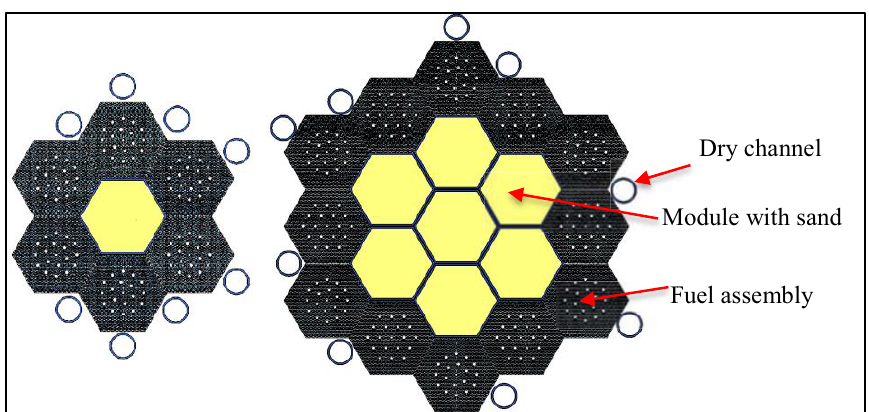
Figure 1. Schematic drawing of experiments with modules with sand.